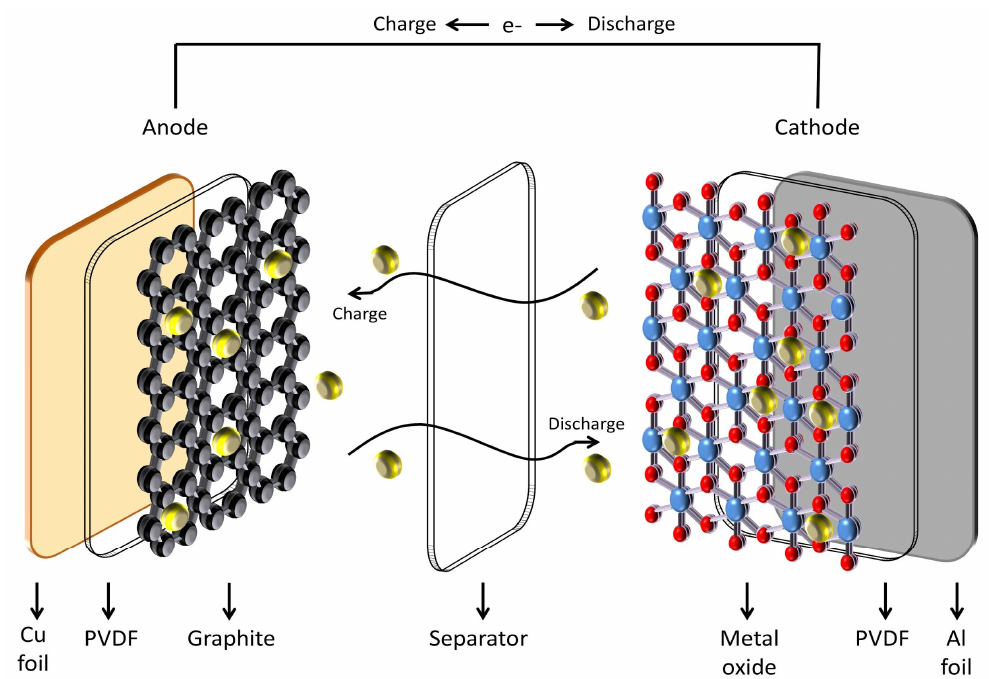
Figure 1. Charge and discharge process in LIBs. Ionic transfer between the cathode and anode [10]. Ref. [11] summarized the mass percentages of each component for three common